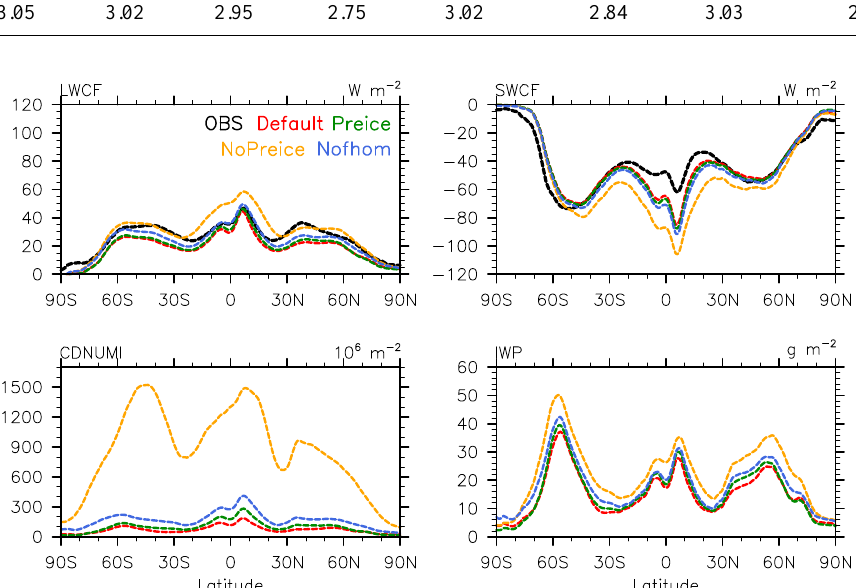
Figure 5. Annual and zonal mean distributions of long-wave and shortwave cloud forcing (LWCF, SWCF), column cloud ice number concentration (CDNUMI) and ice water path (IWP). Black solid line refers to CERES data for cloud forcing (Wielicki et al., 1996). Units are shown in the upper right